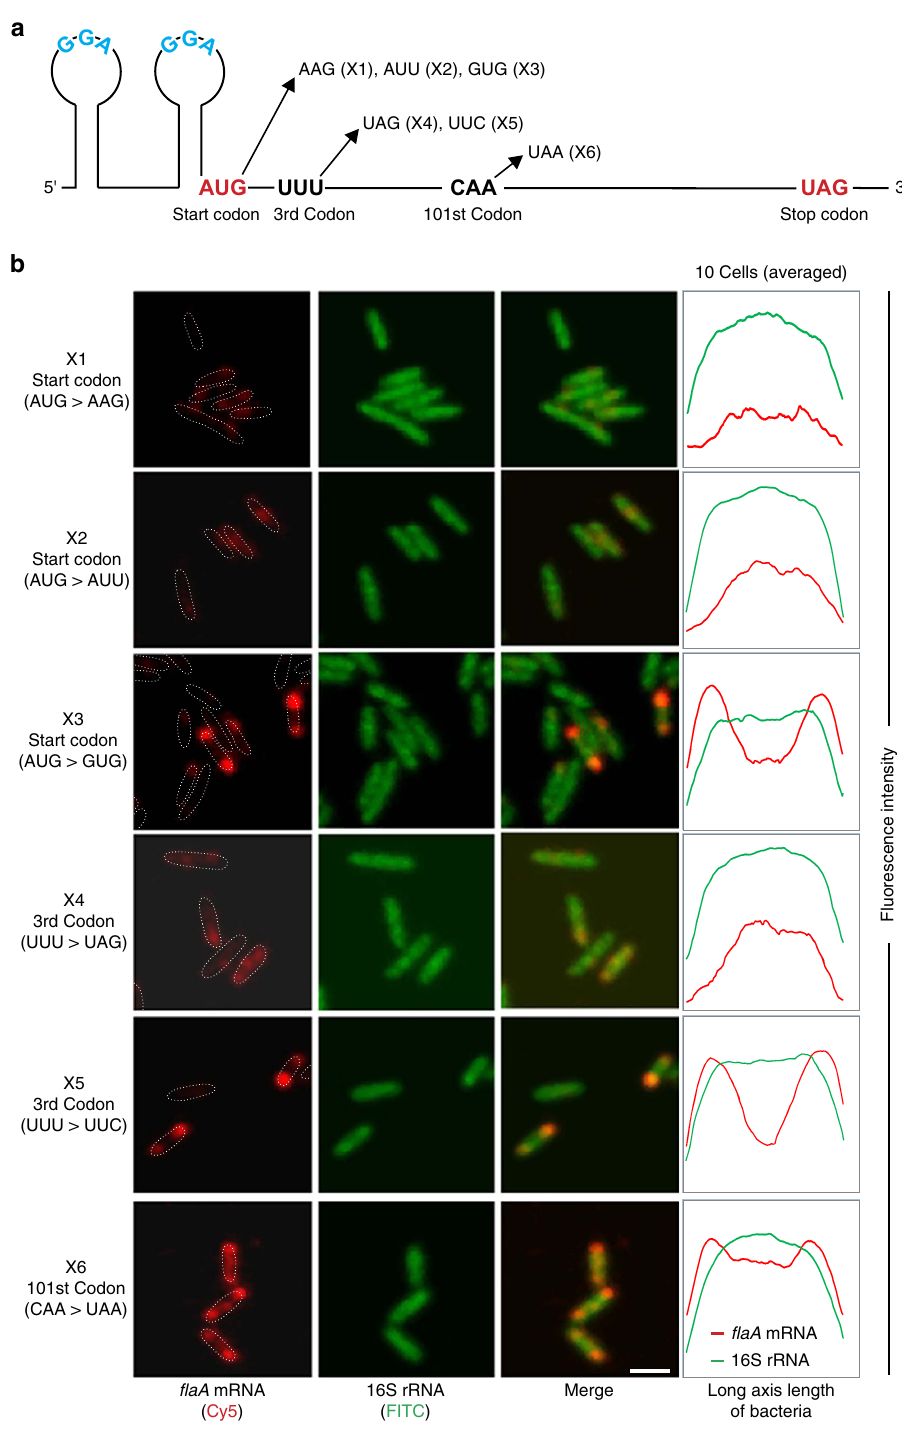
Figure 8 | Translation is required for flaA mRNA localization to the cell poles. ( a ) Point mutations in flaA mRNA that were introduced at the native flaA locus. Mutations X1, X2, X4 and X6 abolish or prematurely stop flaA translation, whereas X3 and X5 represent silent mutations. ( b ) RNA-FISH analysis (Left: confocal microscopy images; Right: averaged fluorescence intensity along the long axis based on 10 cells) of C. jejuni point mutant strains depicted in a . FITC and Cy5 channels were merged in the third rows of the microscopy images (scale bar, 1 m